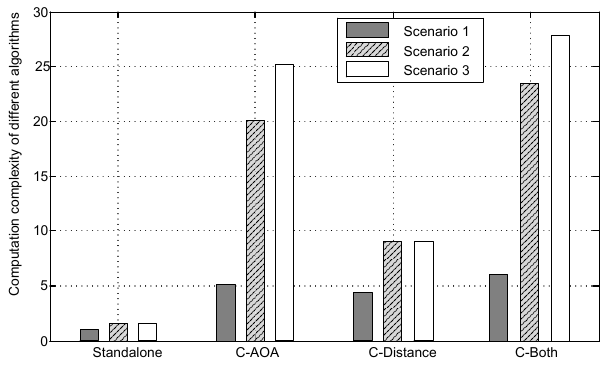
Figure 9. The computation complexity of new collaborative link and user.